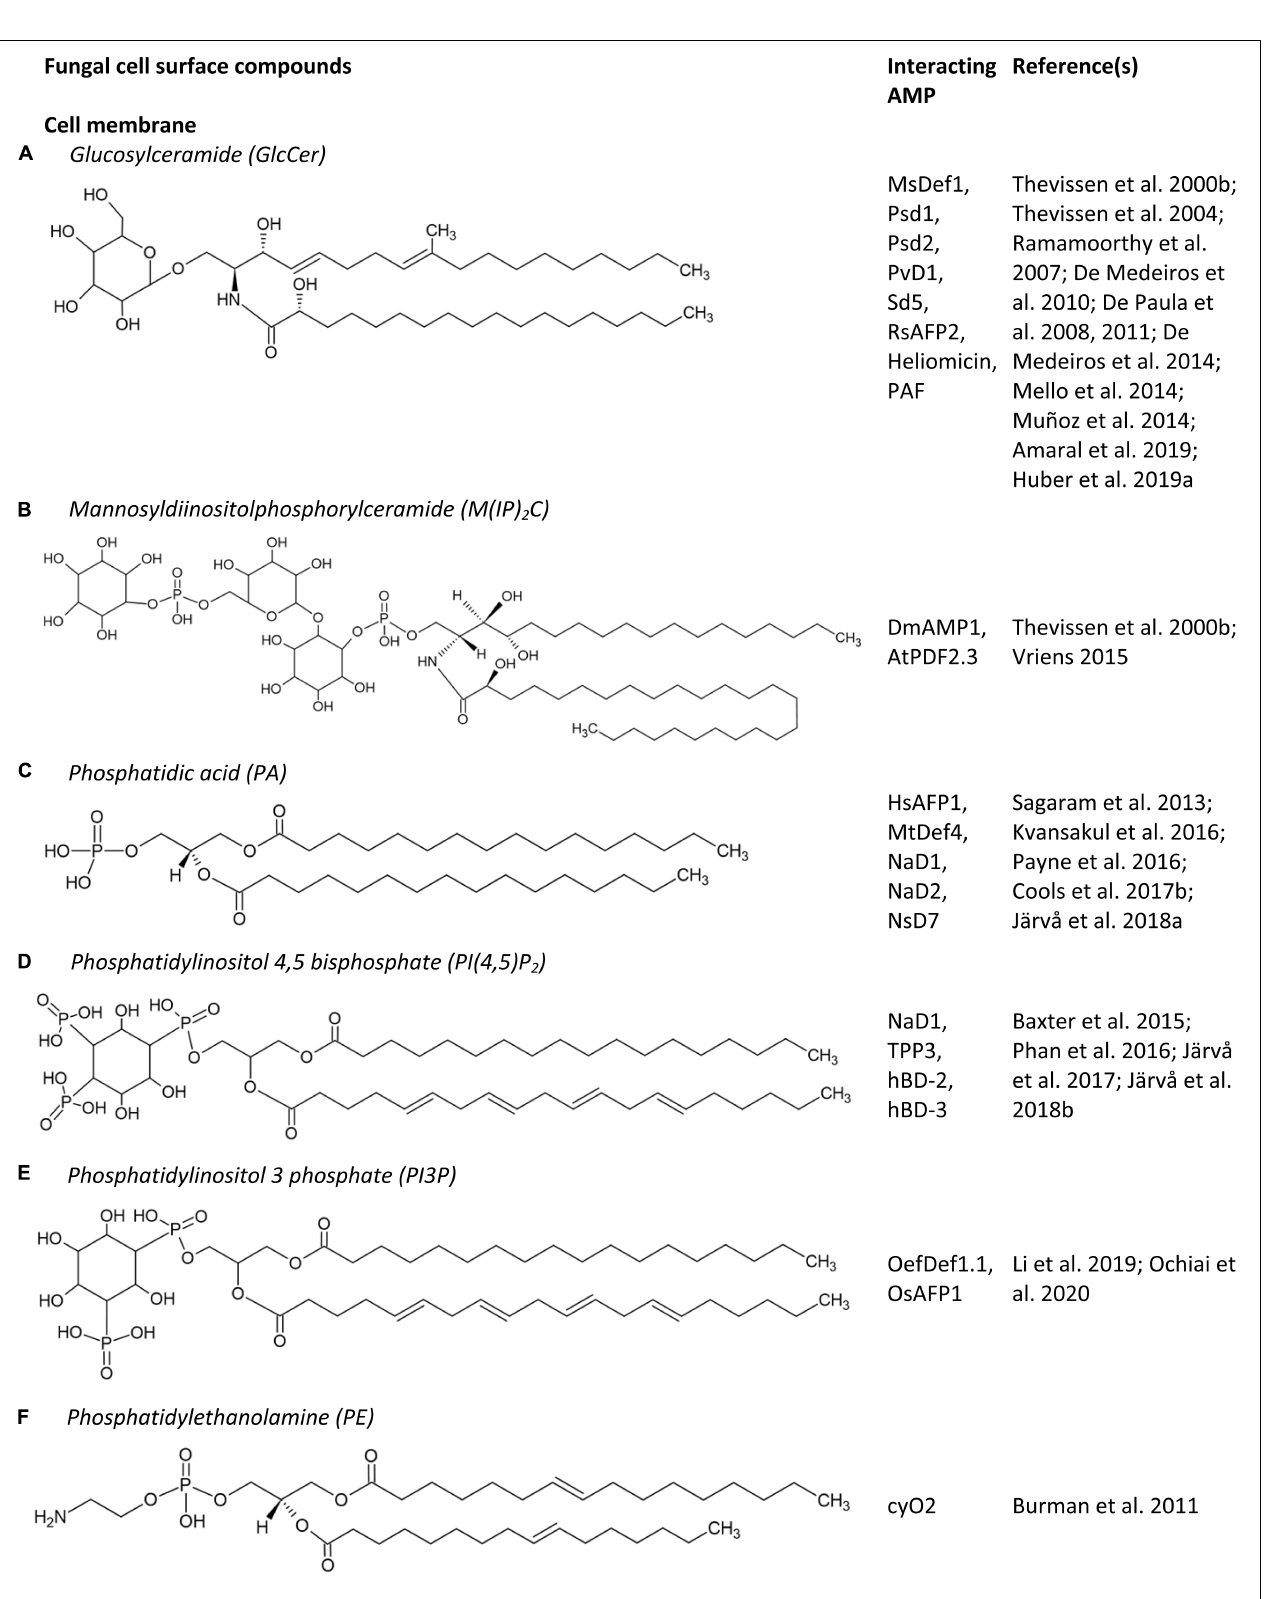
FIGURE 1 | (A–F) Fungal cell surface compounds known to play an important role in the antifungal mode of action of AMPs.